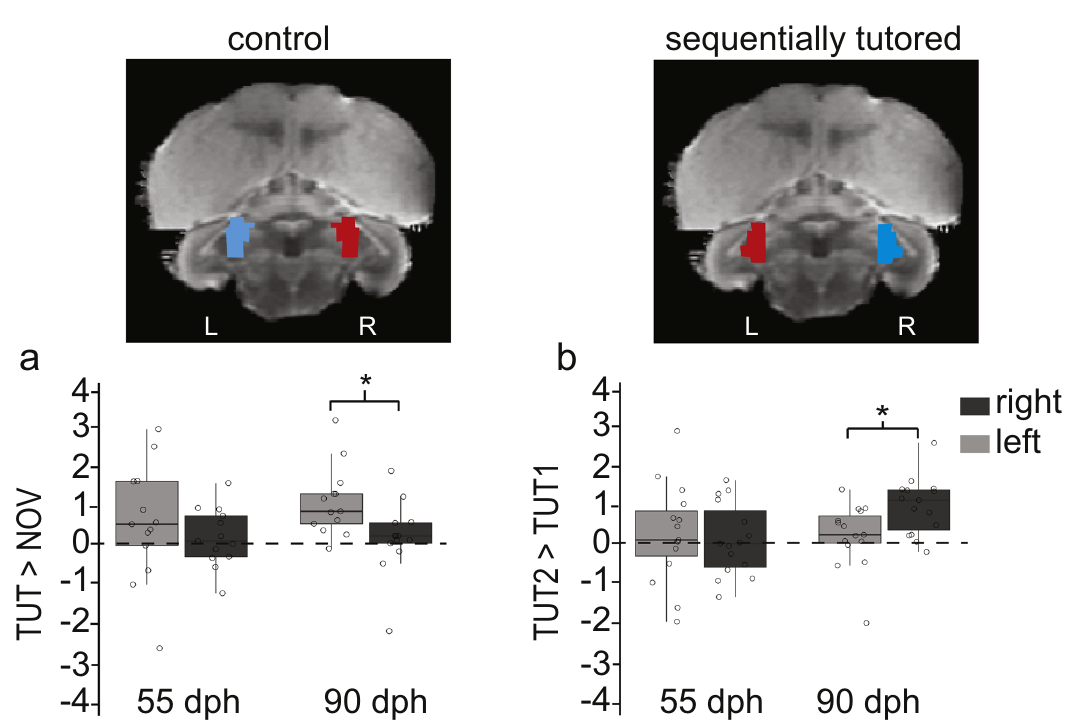
Fig. 4 Development of lateralized tutor-selective responses. Illustrations (top) of the activated cluster (blue) and mirrored (red) regions of interest for the lateralization analysis overlaid on coronal sections of the zebra fi nch MRI atlas. Estimates of differential processing (bottom) of TUT1 songs in ( a ) control birds (% signal change: TUT > NOV), and ( b ) TUT2 songs in sequentially tutored birds (% signal change: TUT2 > TUT1) in the left and right midbrain. The regions of interest for calculating percent signal change were based on the activated clusters for TUT > NOV in Fig. 3f and TUT2> TUT1 in Fig. 3a. Boxplots showing the interquartile range (box), median (black line), and 1st and 3rd quartile; all birds are represented by circles (control: N = 13, sequentially tutored: N = 15). Paired two-tailed t tests were performed, * P < 0.05 between left and right